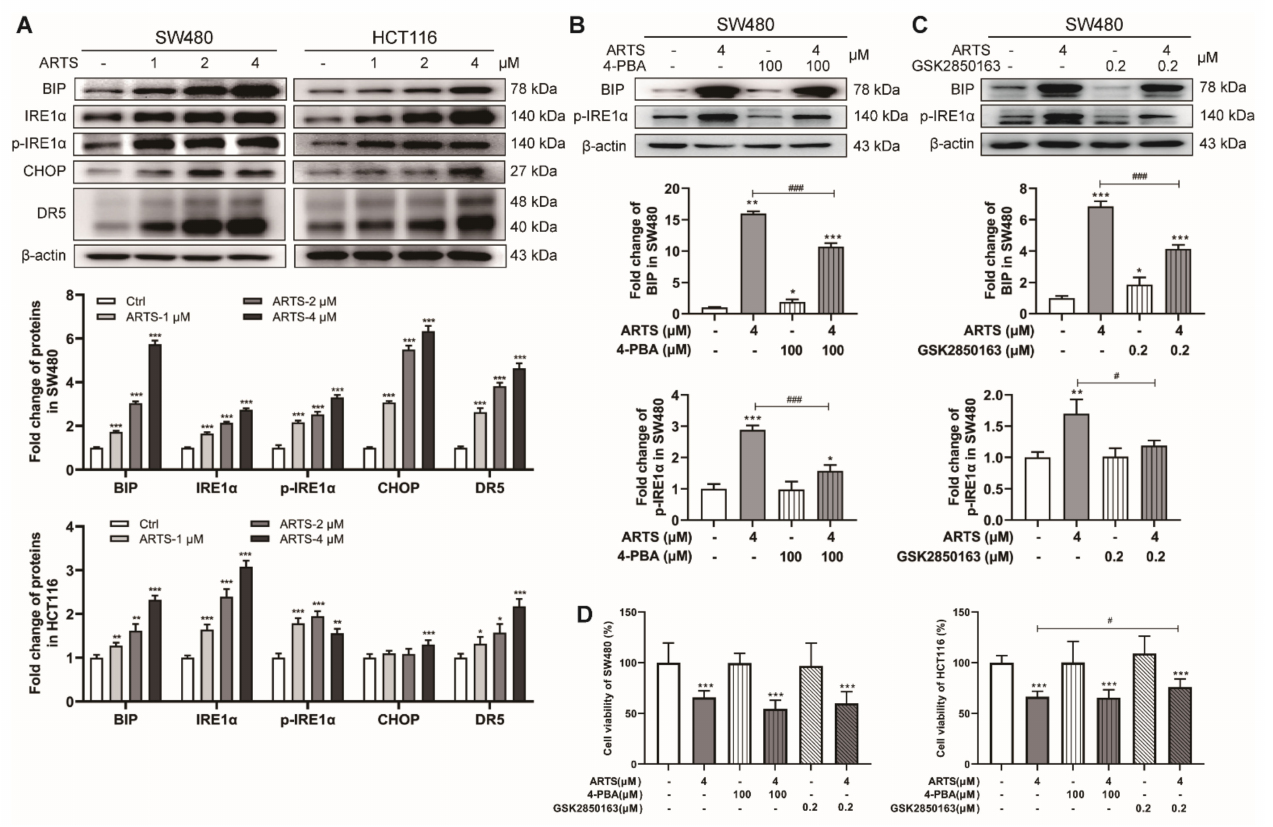
Figure 6. Artesunate induced ER stress and activated UPR via IRE1 α signaling. ( A ) Artesunate induced the expression of ER stress sensor BIP and activated the IRE1 α branch of UPR pathways. The protein levels of BIP, IRE1 α , phosphorylated-IRE1 α (p-IRE1 α ), CHOP, and DR5 were detected by western blotting. ( B ) The ER stress inhibitor 4-PBA and ( C ) IRE1 α inhibitor GSK2350168 helped to reduce the protein levels of BIP and p-IRE1 α . ( D ) GSK2350168 helped to restore cell viabilities in HCT116. 4-PBA was used at a concentration of 100 µ M and added alone or together with artesunate (4 µ M) for 72 h. GSK2350168 was used at a concentration of 0.2 µ M and added alone or together with artesunate (4 µ M) for 72 h. * p < 0.05, ** p < 0.01, and *** p < 0.001 vs. Ctrl. # p < 0.05, ### p < 0.001 vs. cells treated with artesunate alone. Data were shown as mean ±